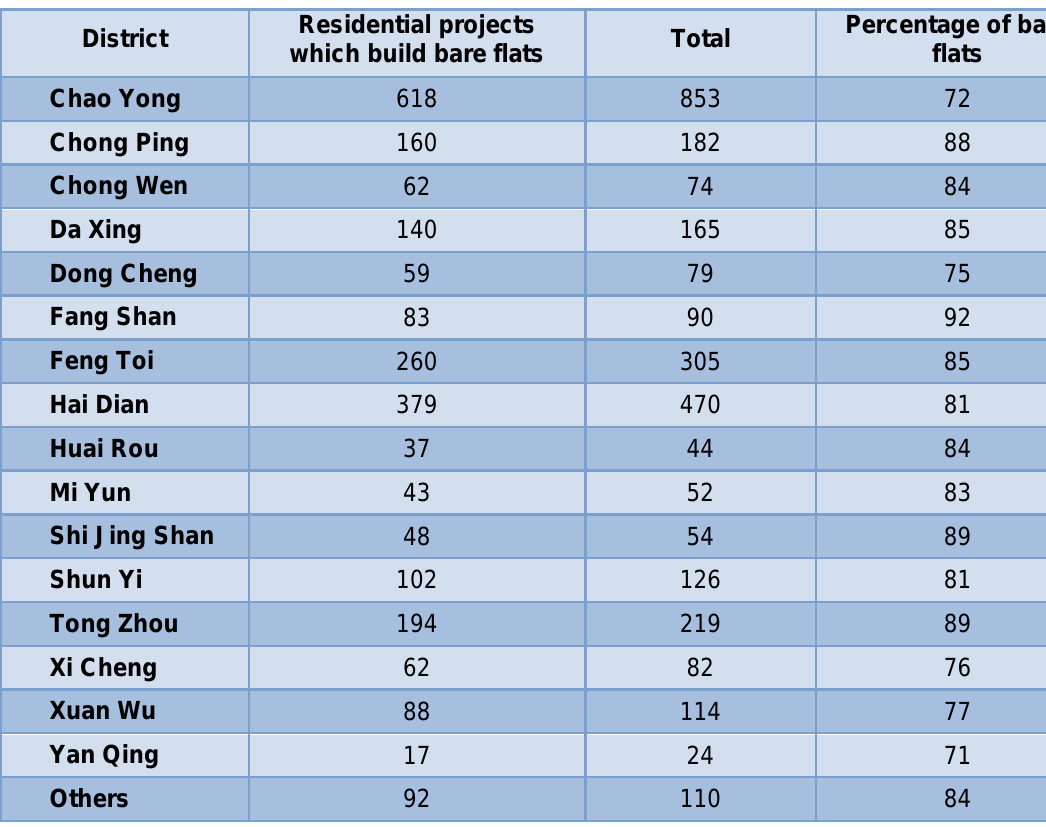
Table 2 Percentage of bare flats in Beijing from 1997 - 2008 (Li,